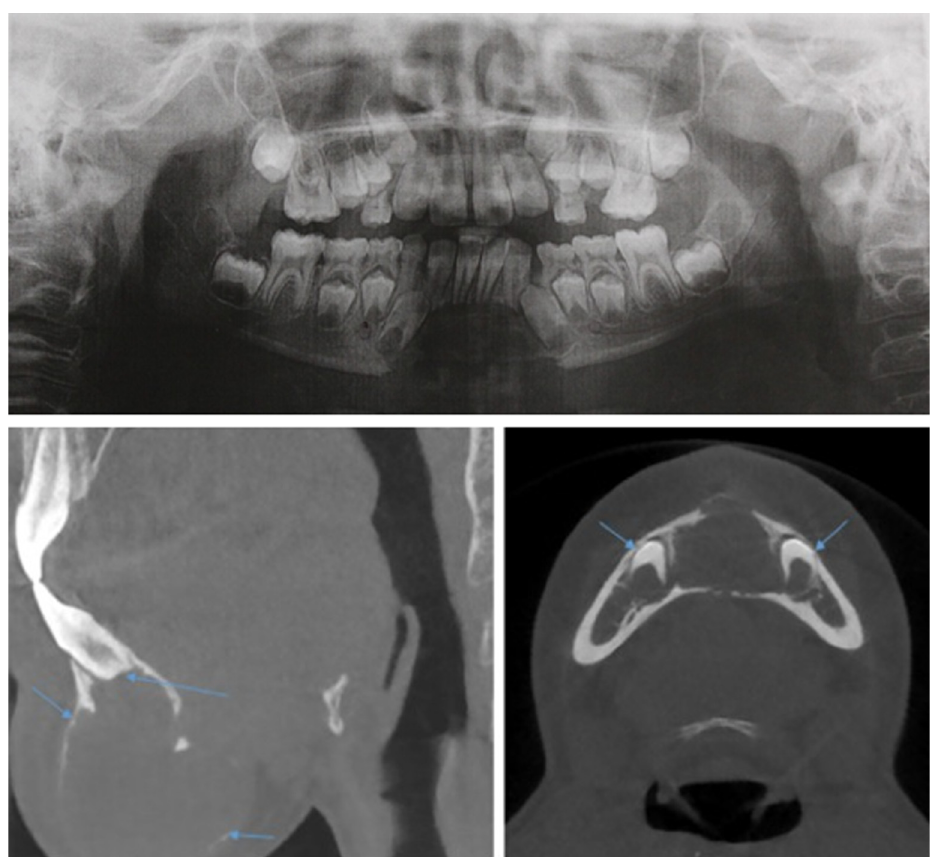
Fig. 2. Preoperative orthopantomogram and cone-beam computed tomography. Top: Orthopantomogram revealing an osteolytic lesion of the mandibular symphysis, with well-de fi ned margins, fl anked by teeth roots 33 and 43 on either side and linked to the root resorption of teeth 31 and 41. Bottom left: sagittal section CBCT focused on no. 31 (tooth rhizalysis). An osteolytic lesion with a thin bony wall can be observed. Bottom right: axial CBCT section focused on the roots of teeth 33 and